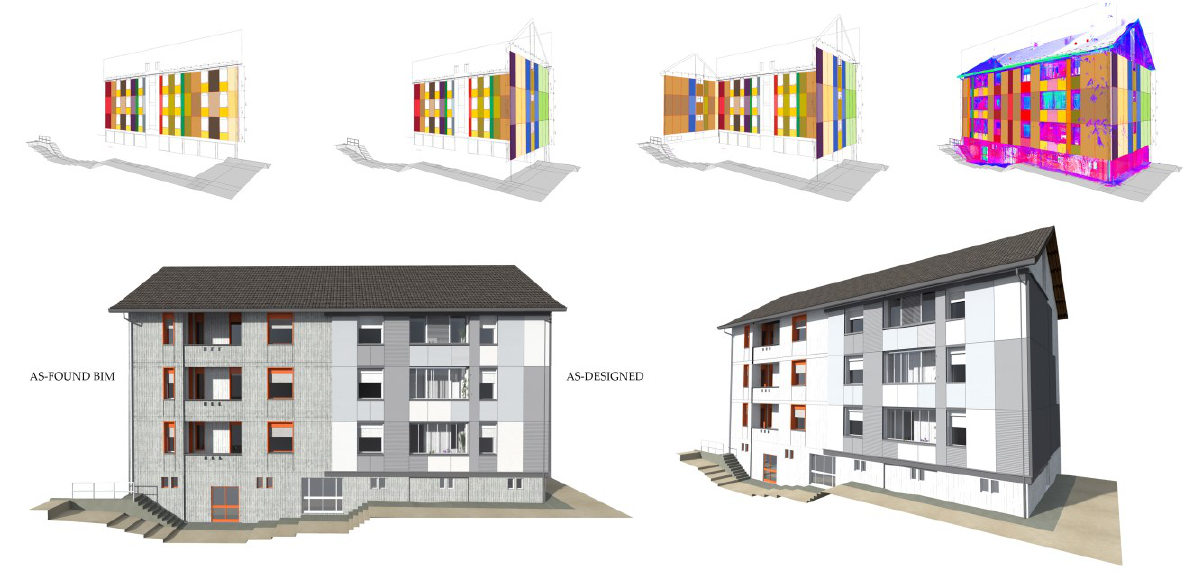
Figure 11. Top: as-designed façades. Bottom: as-found (left) and as-designed phases (right) in the same BIM project.